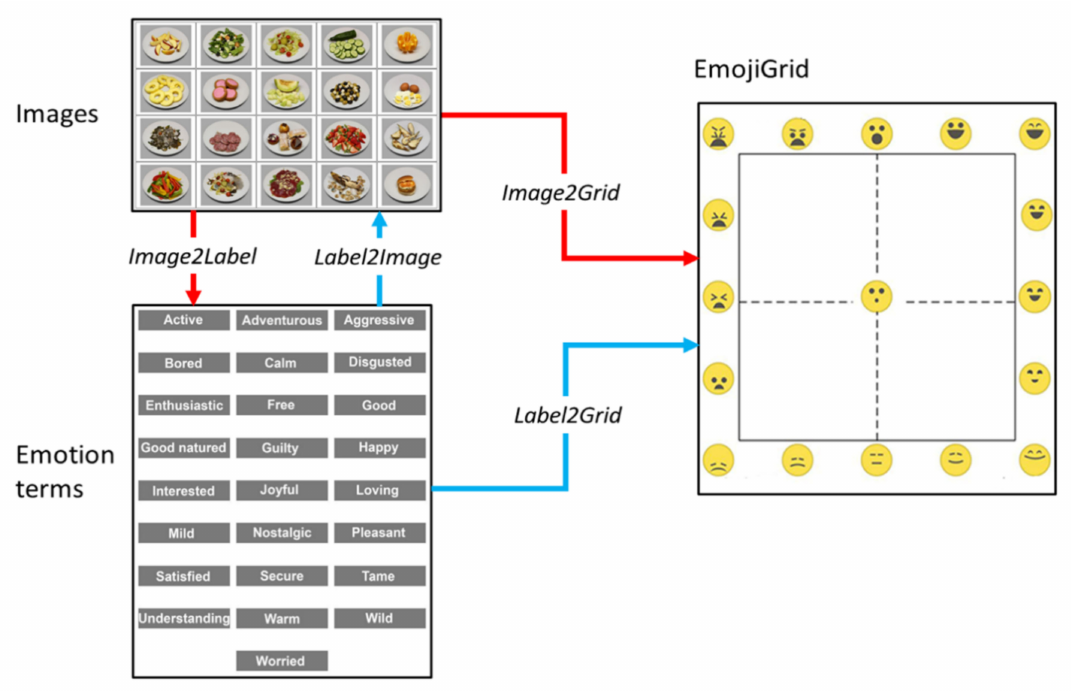
Figure 2. The four different tasks (represented by the arrows) that were investigated in this study. Red arrows: matching tasks. Blue arrows: labeling tasks. Image2Grid task: matching food images to the EmojiGrid. Image2Label task: matching food images to emotion terms. Label2Image task: labeling food images with emotion terms. Label2Grid task: labeling the EmojiGrid with emotion